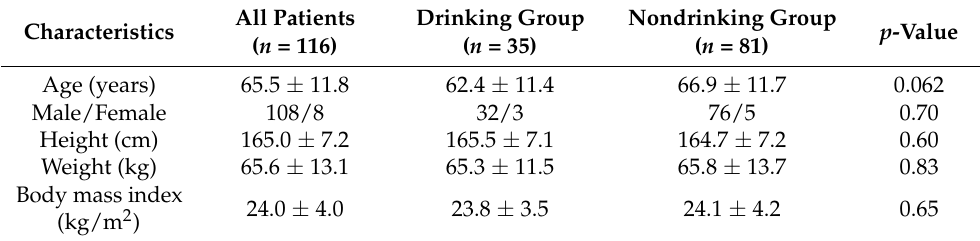
Table 1. Comparison of physical backgrounds of patients with alcoholic cirrhosis between the drinking and nondrinking